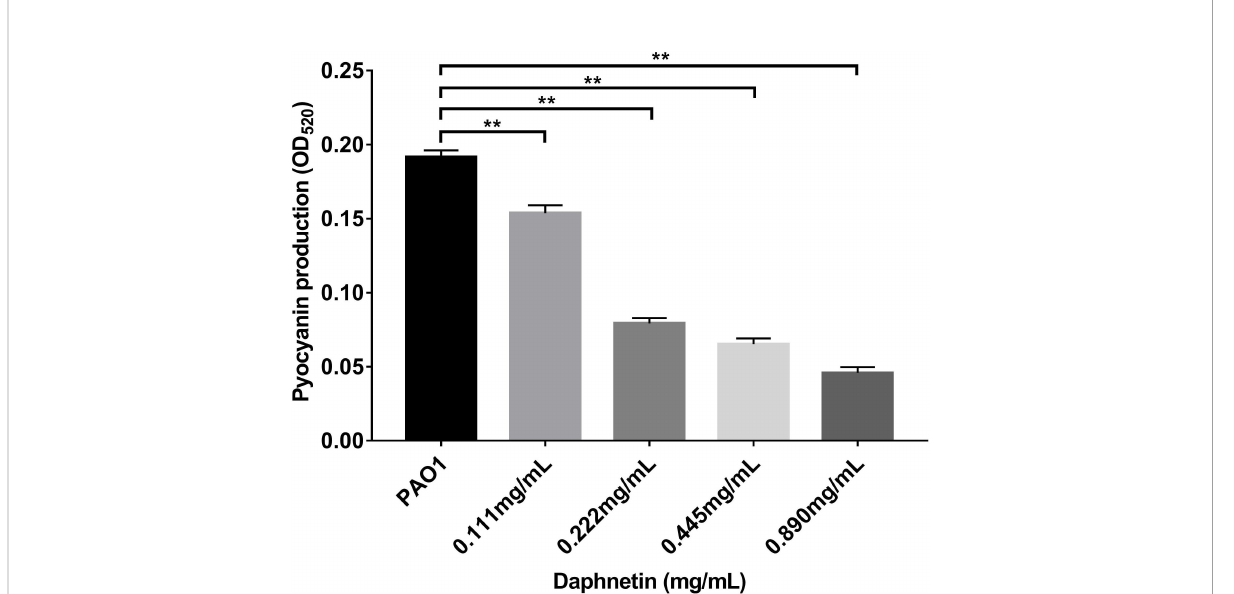
FIGURE 10 Effects of daphnetin (DAP) on pyocyanin production by P. aeruginosa . Pyocyanin production was measured at OD 520 by a quantitative chemical assay. Error bars indicate the standard deviations. Results are represented as the mean ± SD; ** indicate P-values <0.01. ANOVA was used to compare the groups (600×600